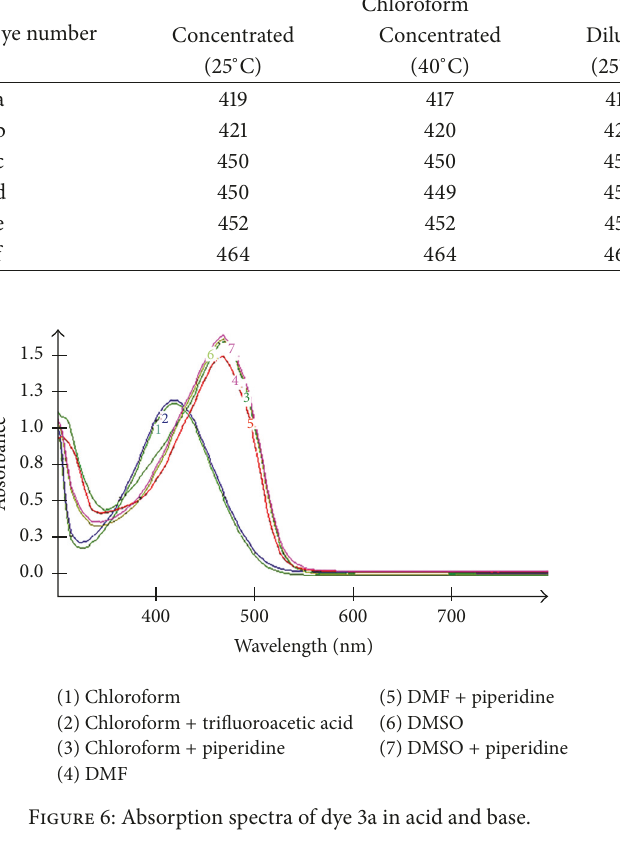
Figure 6: Absorption spectra of dye 3a in acid and